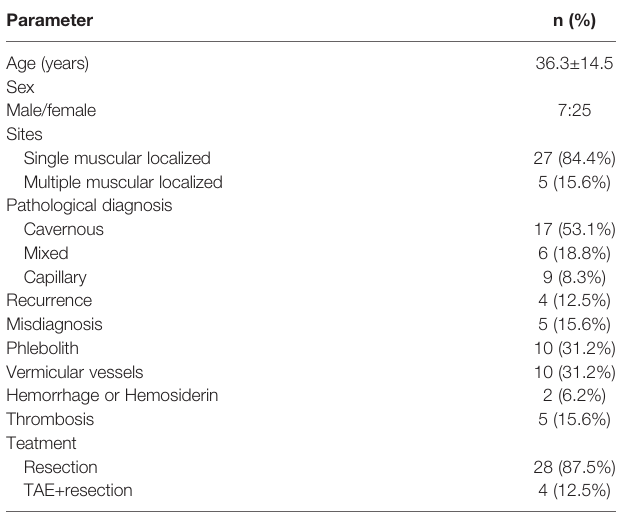
TABLE 1 | Clinical and pathological characters of all 32 patients with intramuscular hemangiomas.